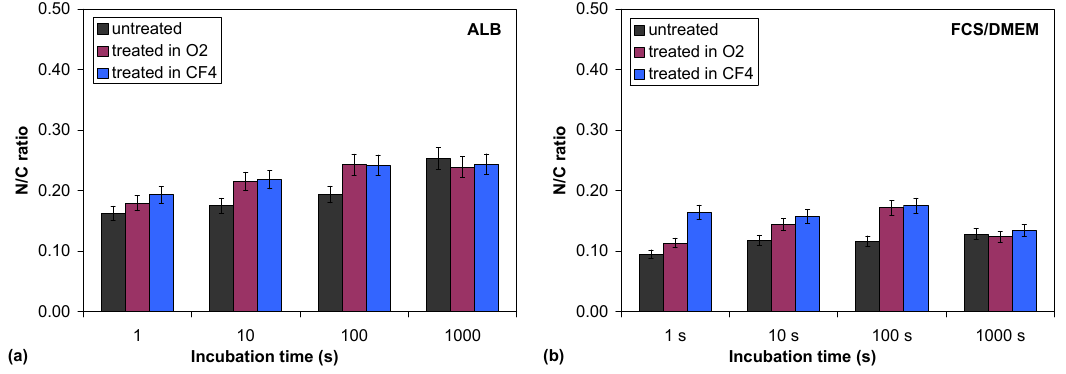
Figure 6. Comparison of the N/C ratio after incubation of untreated PET samples and O plasma-treated samples in albumin solution ( a ) and FCS/DMEM solution ( b and CF 4